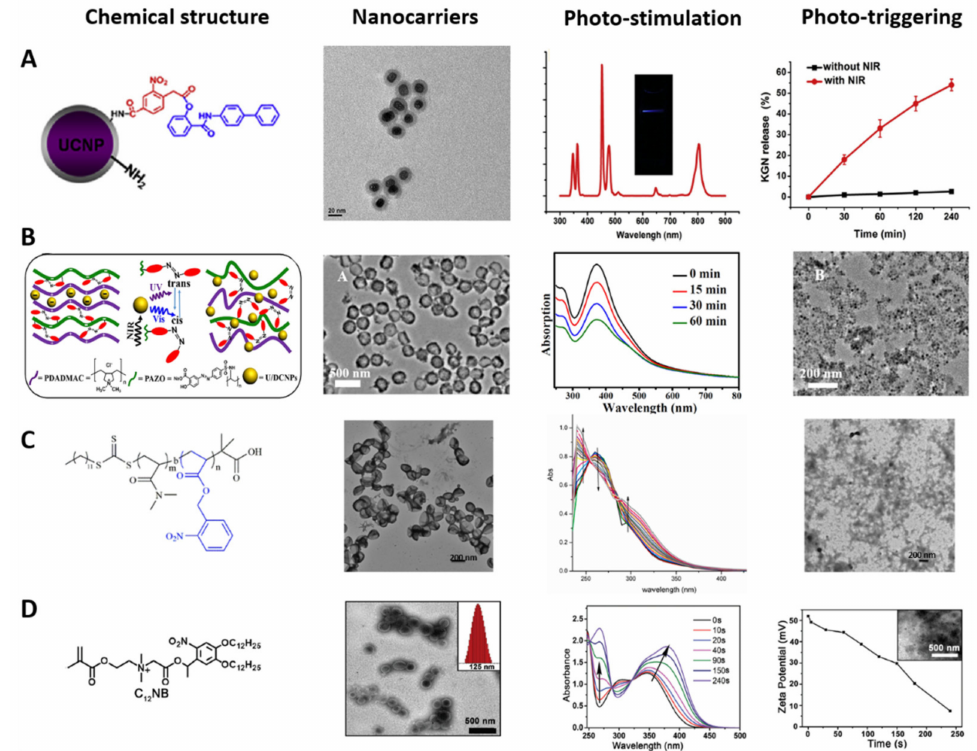
Figure 6. Chemical structure, TEM and AFM images, photostimulation, and phototriggering charac- terization of photosensitive nanocarriers: ( A ) photosensitive-nanospheres based on UCNPs, reprinted with permission from [220], copyright 2016, Elsevier; ( B ) photosensitive layer-by-layer polymer, reprinted with permission from [221], copyright 2018, John Wiley and Sons; ( C ) o-nitrobenzyl poly- mer, reprinted with permission from [140], copyright 2020, Multidisciplinary Digital Publishing Institute; and ( D ) terminal o-nitrobenzyl polymer, reprinted with permission from [222], copyright 2020, Royal Society of